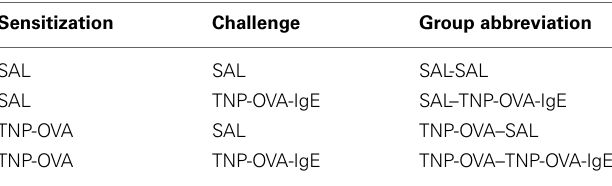
Table 2 | Mouse groups included in the severe airway inflammation